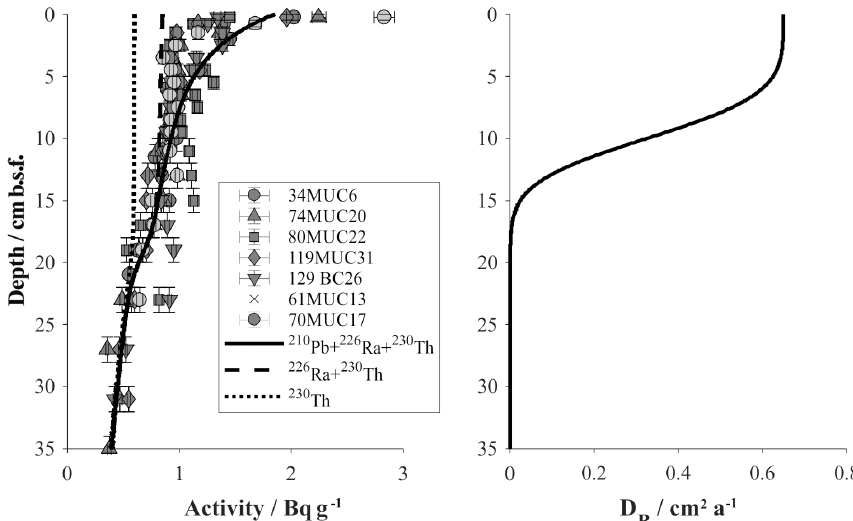
Figure 7. Model results of the faunal bioturbation activity in reference and DEA outside track sediments based on measured 210 Pb activities. Left: model curves indicate total 210 Pb activity (solid) and supported contributions by 230 Th (dotted) and 226 Ra (dashed). Right: bioturbation intensity profile derived for the background